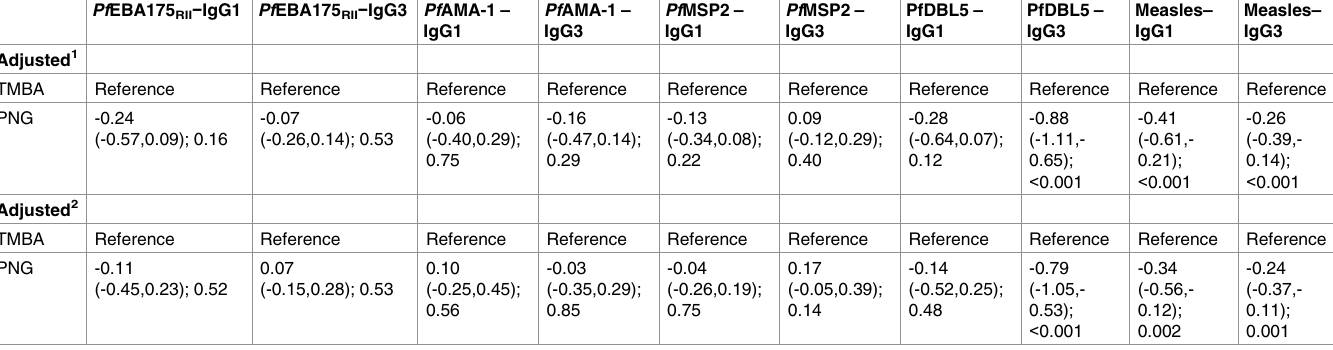
NB–Coefficients represent the differences in cord antibody levels by study site after adjustment for maternal antibody levels. Abbreviations: TMBA = Thailand-Myanmar Border Area; PNG = Papua New Guinea. 1 –Adjusted for log 2 maternal levels. 2—Adjusted for log 2 maternal levels, gravidity (primigravid/multigravid) and gestational age at delivery (weeks).